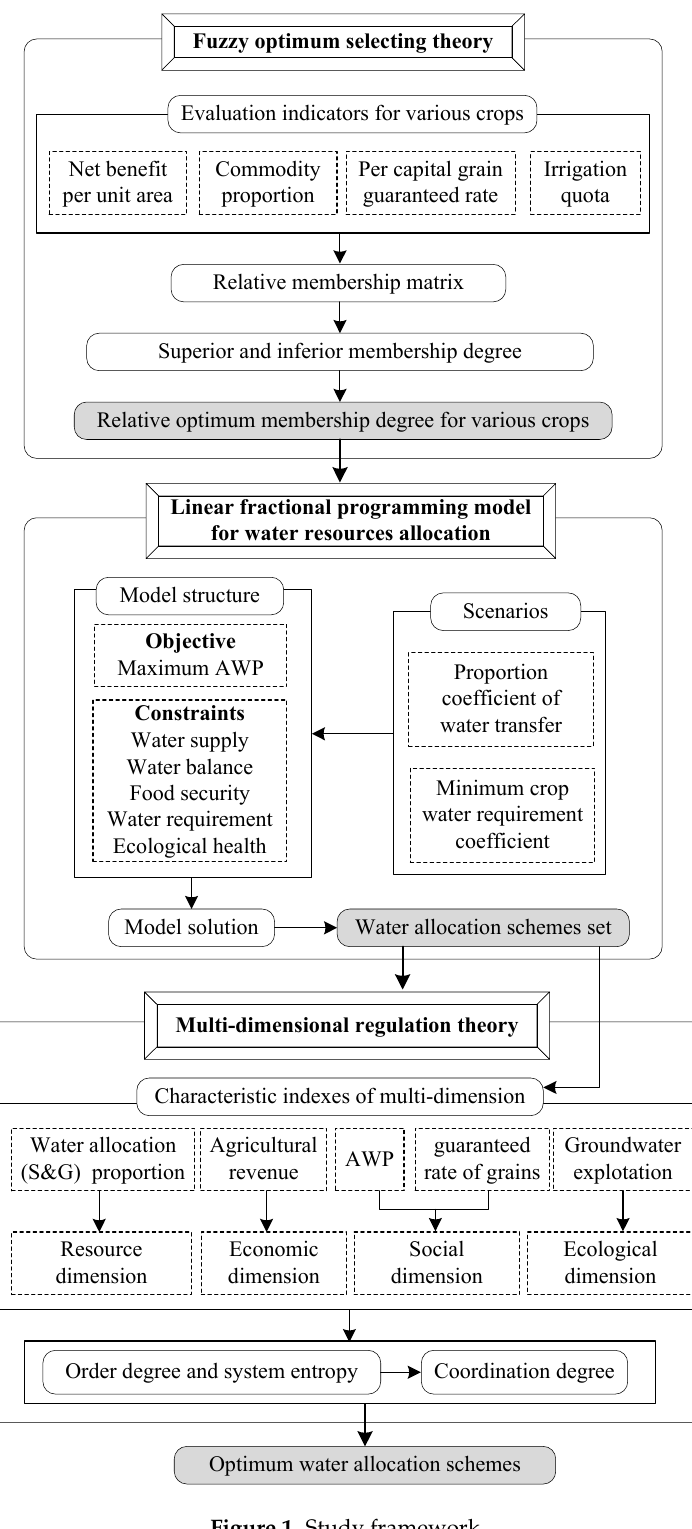
Figure 1. Study framework.